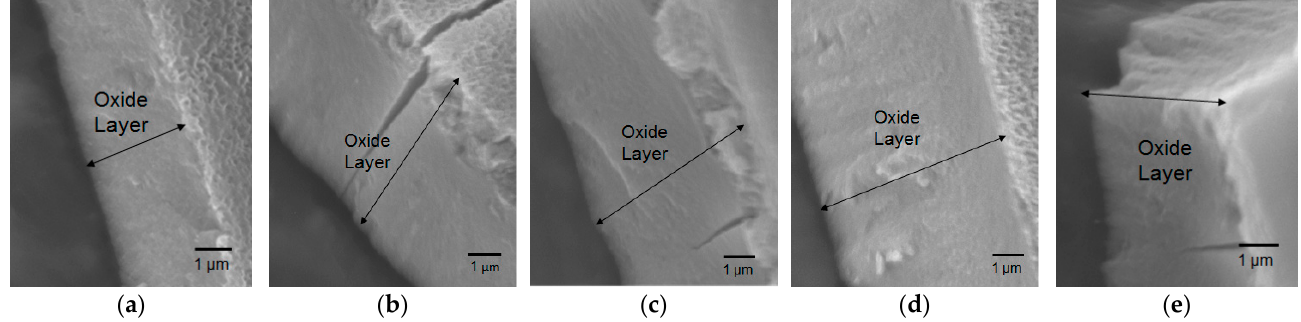
Figure 1. SEM images (10,000× magnification) for samples ( a ) 5CD-5GA; ( b ) 10CD-5GA; ( c ) 15CD-5GA; ( d ) 10CD-0GA, and ( e ) 10CD-10GA. The images show the cross-section of the oxide layers formed during anodization at varying current densities and gallic acid concentrations.